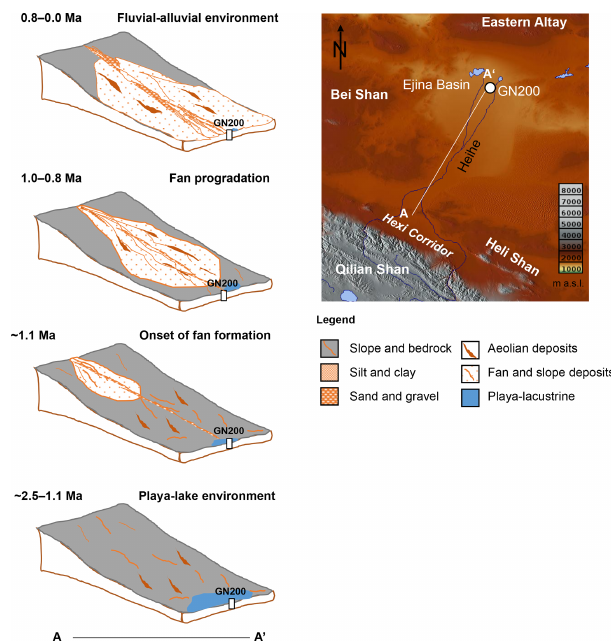
Figure 10. Conceptual model illustrating the progradation of the Heihe alluvial fan into the Ejina Basin. (Service layer credits: SRTM under CC